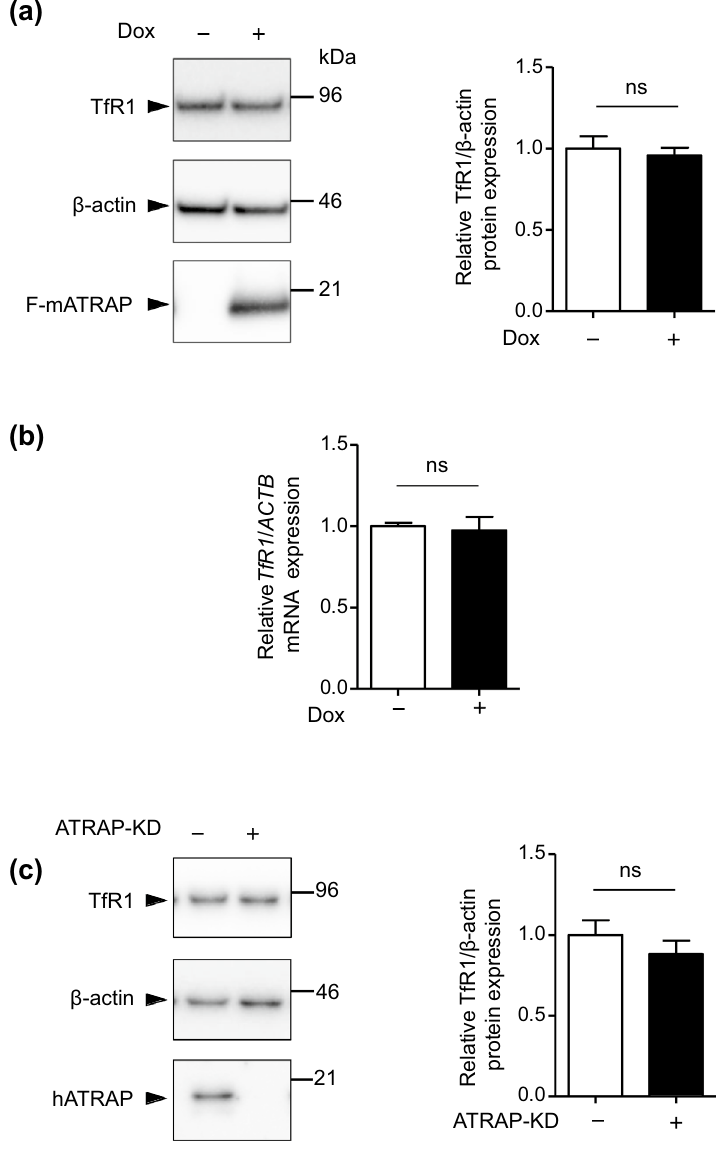
Figure 5. Effects of ATRAP expression on TfR1 expression. ( a , c ) Western blot analysis of TfR1 protein expression ( b ) and RT-qPCR analysis of TfR1 mRNA expression ( a ) in Dox-inducible HEK293_F-mATRAP cells, with or without Dox treatment (Dox+/−). ( c ) in HEK293 cells treated with siRNA targeted ATRAP (ATRAP-KD) or control siRNA (control). ( a , c ) Representative western blot probed with indicated antibodies are shown in the left panel. Quantitative results are plotted in the right panel. Unpaired t -test, ( a ) n = 11 or ( c ) n = 6. The data shown are presented as the mean ± SEM. ( b ) Quantitative results of RT-qPCR are shown. Unpaired t -test, n = 3. The data shown are presented as the mean ±